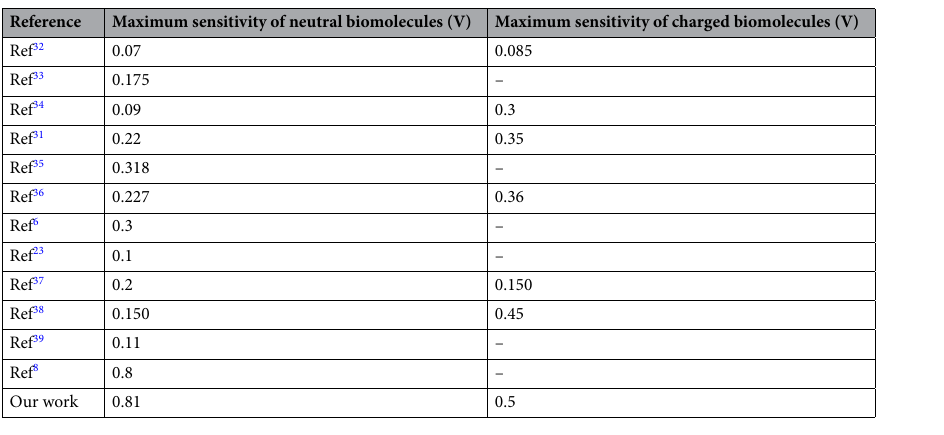
Table 2. Benchmarking with contemporary works of